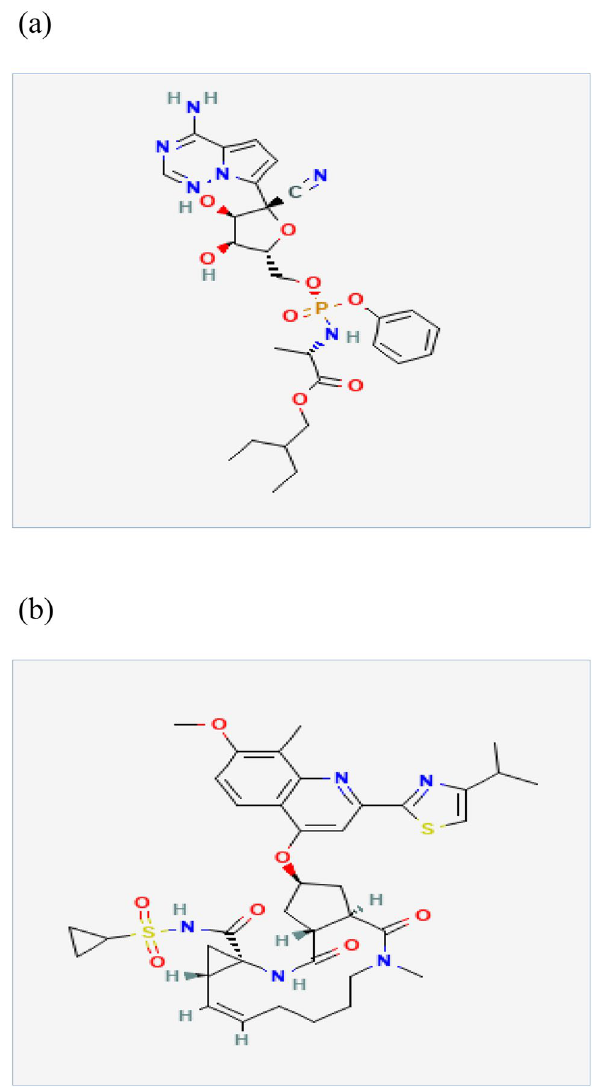
Figure 1. Chemical structure of ( a ) Remdesivir and ( b )